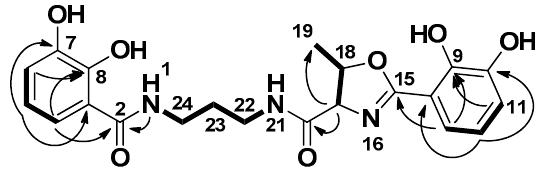
Figure 3. Key COSY (bold) and HMBC (arrow) correlations for serratiochelin A ( 1 ). Table 1. 1 H- and 13 C-NMR data for serratiochelin A ( 1 ) and C ( 2 ) in DMSO- d 6 .